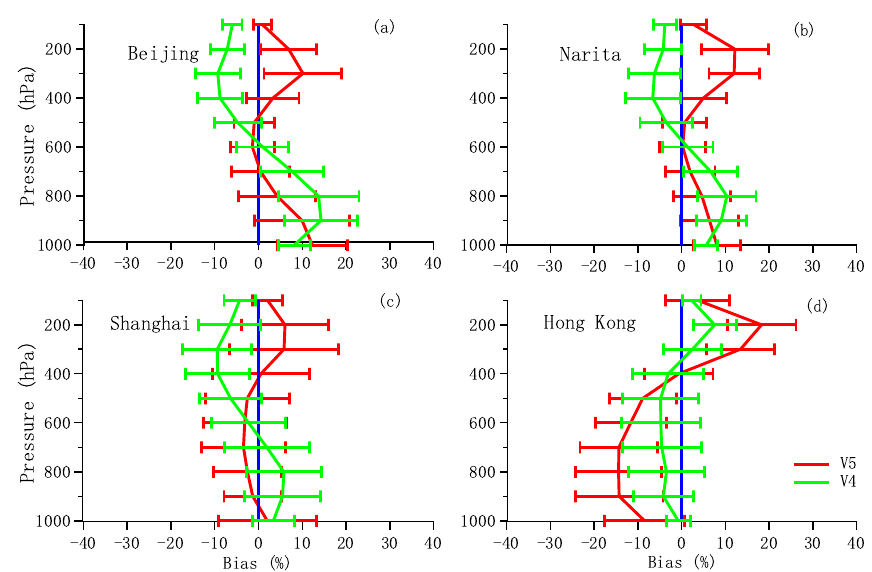
Figure 2. Relative bias of CO profiles (in %) between MOPITT and MOZAIC data (smoothed with the MOPITT averaging kernels; see Eq. 1) from 2003 to 2005 at Beijing, Narita, Shanghai, and Hong Kong for MOPITT V4 and V5 data. The number of profiles for the comparison is 18, 23, 11, and 15, respectively, at Beijing, Narita, Shanghai, and Hong Kong. The error bars indicate the interquartile range of the mean.